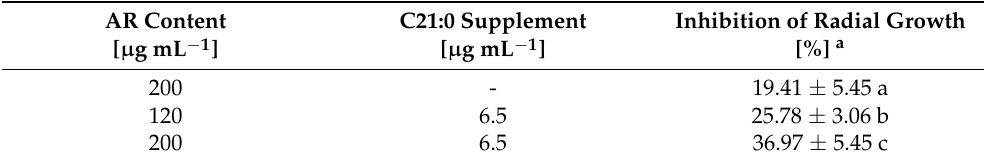
Table 5. The effect of rye 5- n -alk(en)ylresorcinol supplementation with synthetic C21:0 homologue on the reduction of mycelial growth of Rhizoctonia solani